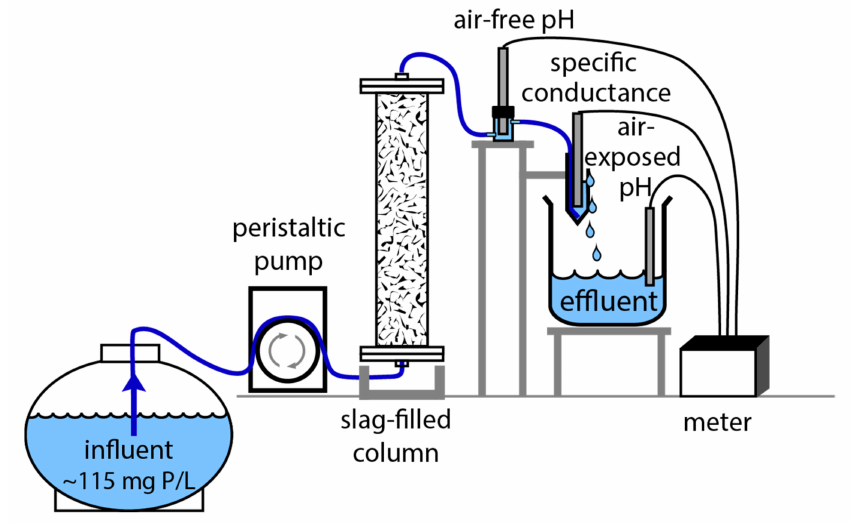
Figure 1. Schematic diagram of flow-through column